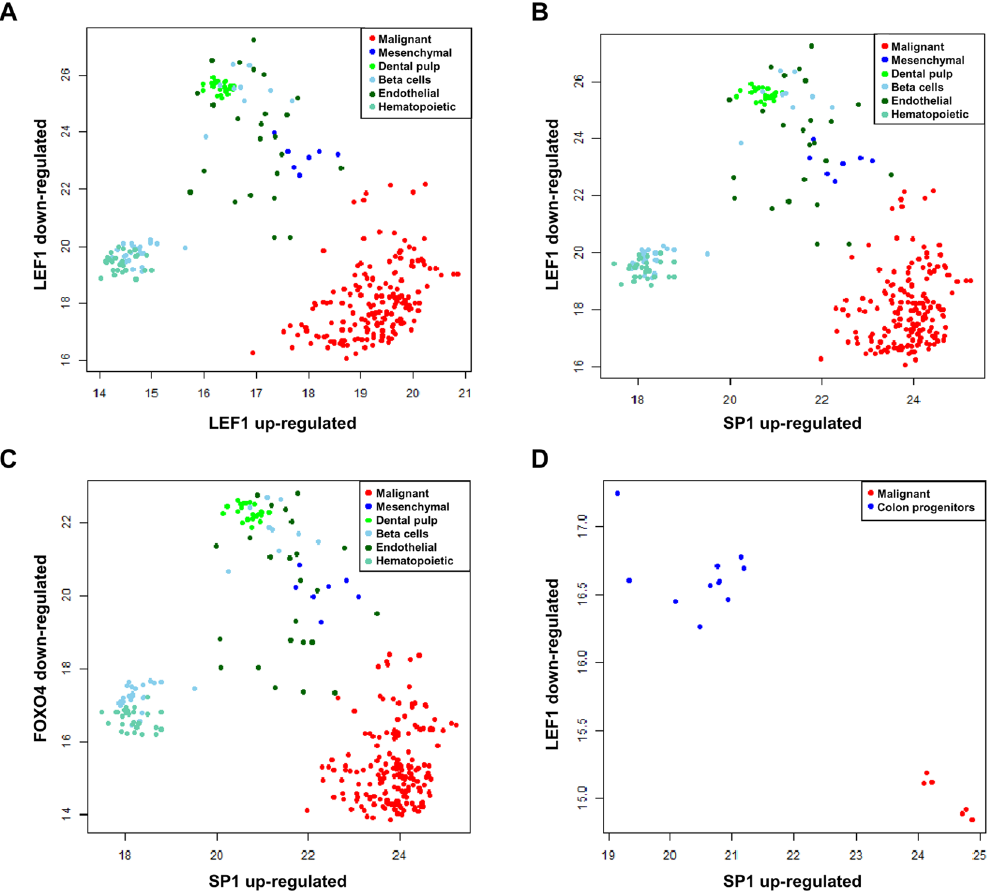
Figure 3. Projections of the characteristic direction on the LEF1 and SP1 regulons. Tumorigenic cells show a consistently higher LEF1 activity, while SP1 activity differentiates epithelial and mesenchymal